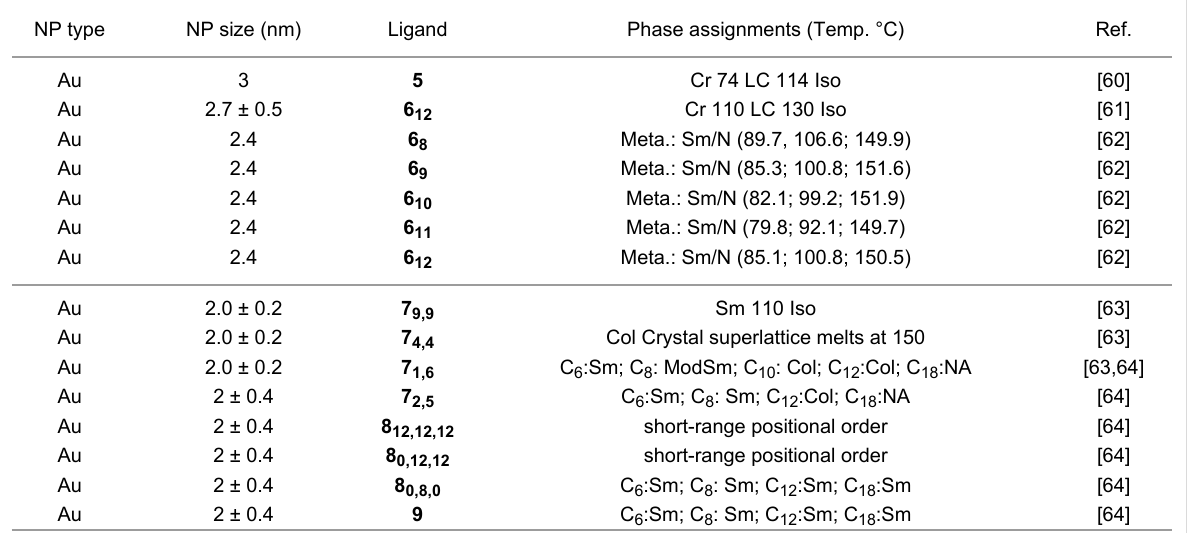
Table 1: Summary of the phase behaviour of the hybrid NPs with rodlike ligands discussed in the text. a